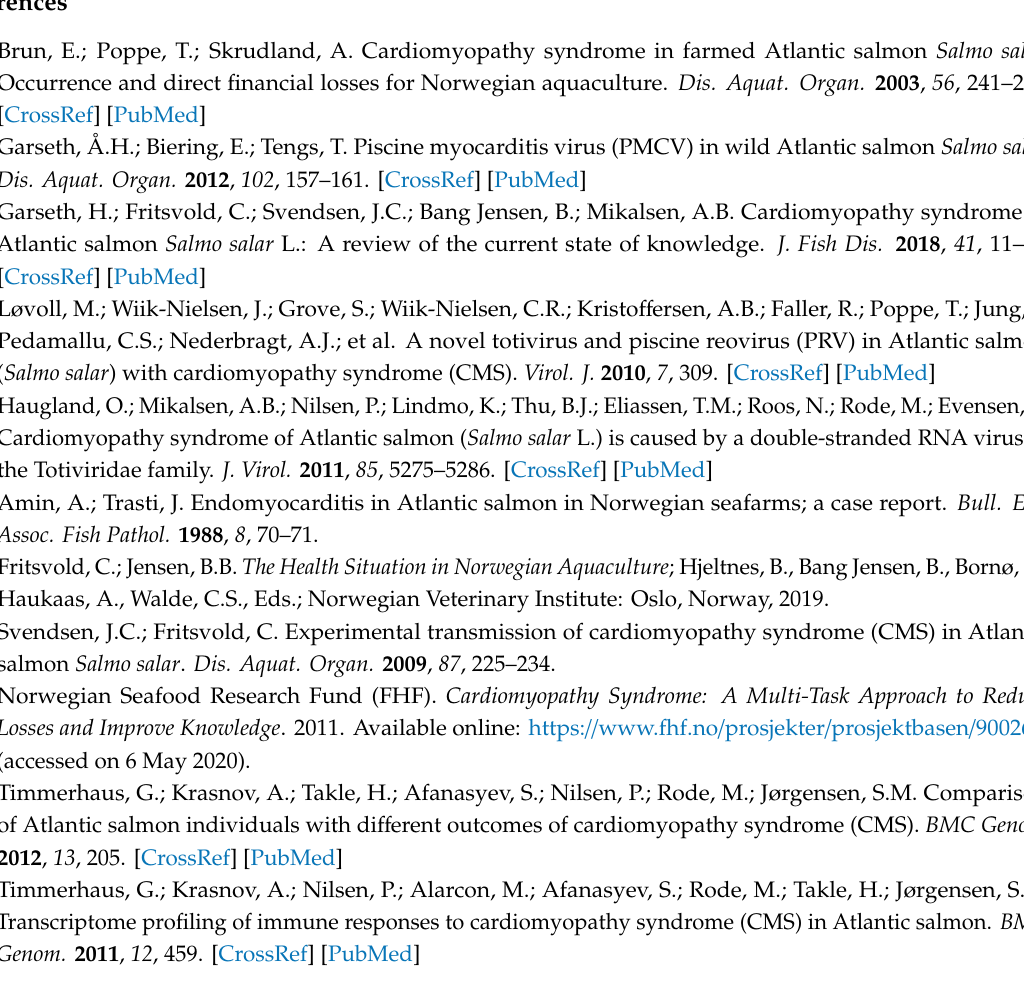
Table S1: List of genes within the two QTL regions reported in this study along with their putative products and